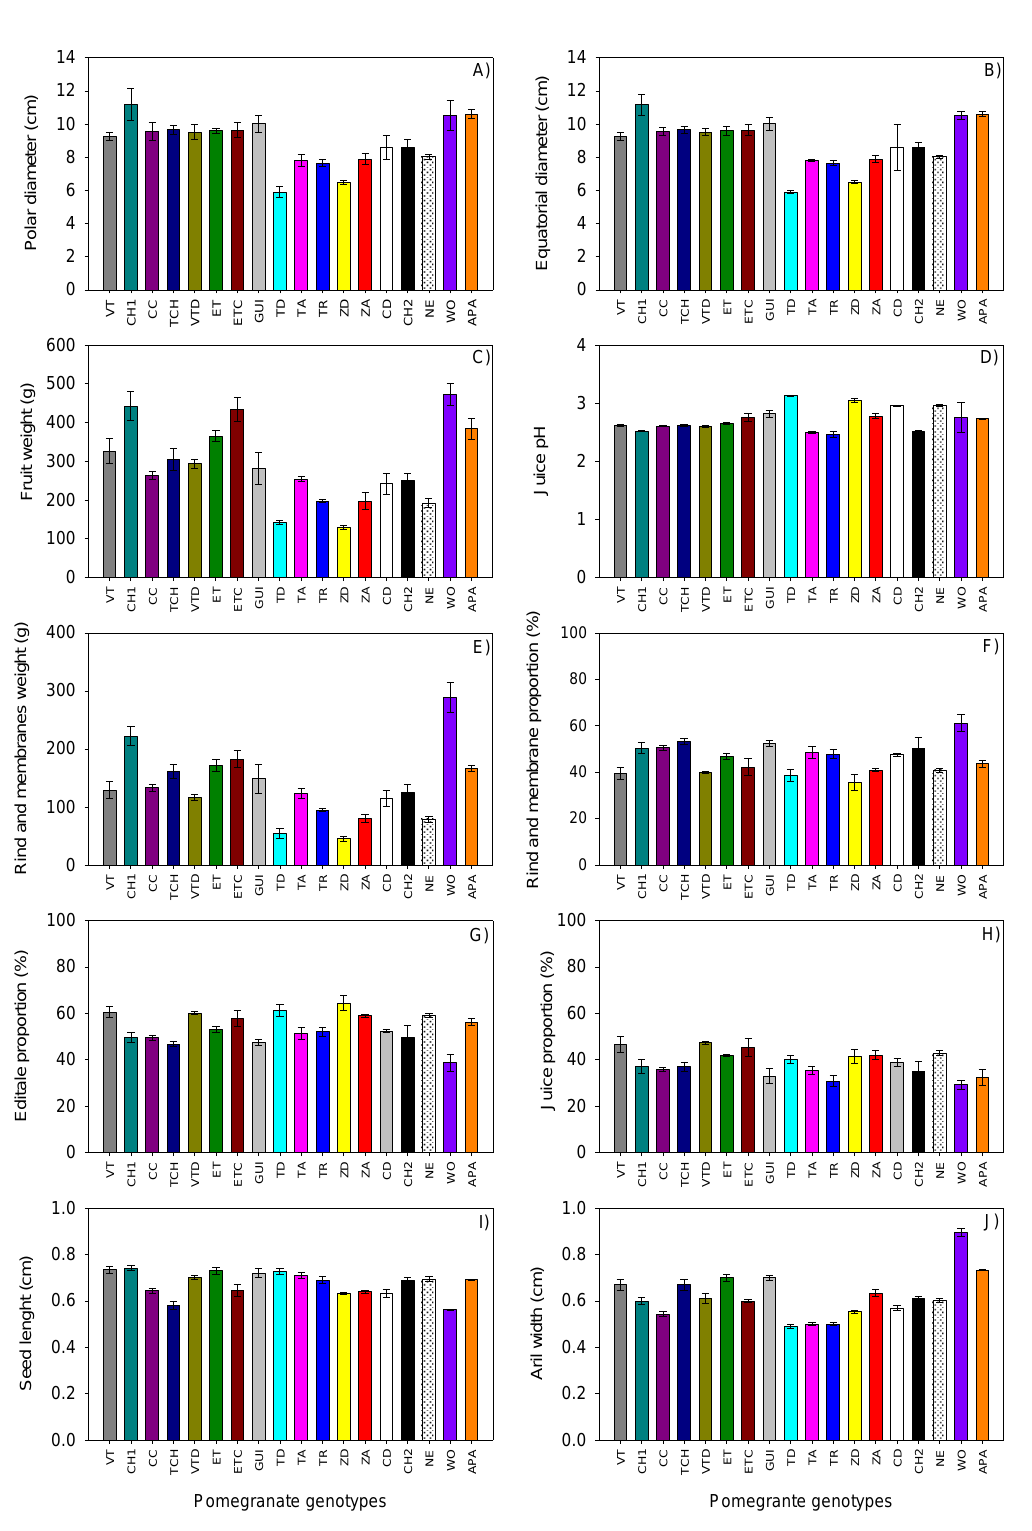
Figure 1. Mean value of the most important fruit traits (according to the PCA). ( A ) Polar diameter, ( B ) Equatorial diameter, ( C ) Fruit weight, ( D ) Juice pH, ( E ) Rind and membranes weight, ( F ) Rind and membrane proportion, ( G ) Editable proportion, ( H ) Juice proportion, ( I ) Seed length, ( J ) Aril width of 18 pomegranate genotypes from southern Jalisco. VT (Verde tecatona), CH1 (Chichona1), CC (Cuco criolla), TCH (Tecatona chapeada), VTD (Verde tecata delgada), ET (El t í o), ETC (El t í o criolla), GUI (Guizar), TD (Toro D), TA (Toro A), TR (Toro R), ZD (Zapote D), ZA (Zapote A), CD (Cuco D), CH2 (Chichona 2), NE (Negra), WO (wonderful), APA